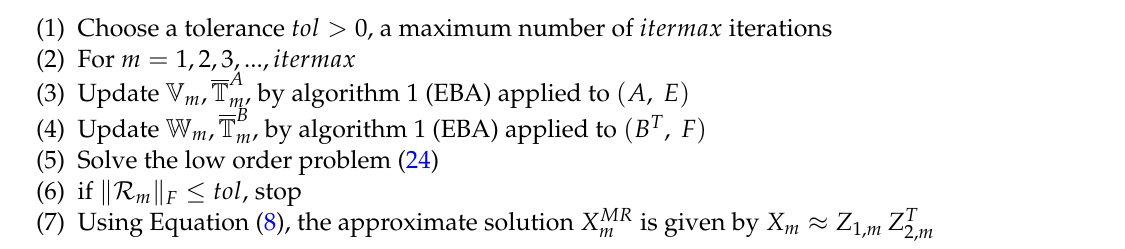
Algorithm 4. The Minimal Residual (MR) Method for Nonsymmetric Stein Matrix